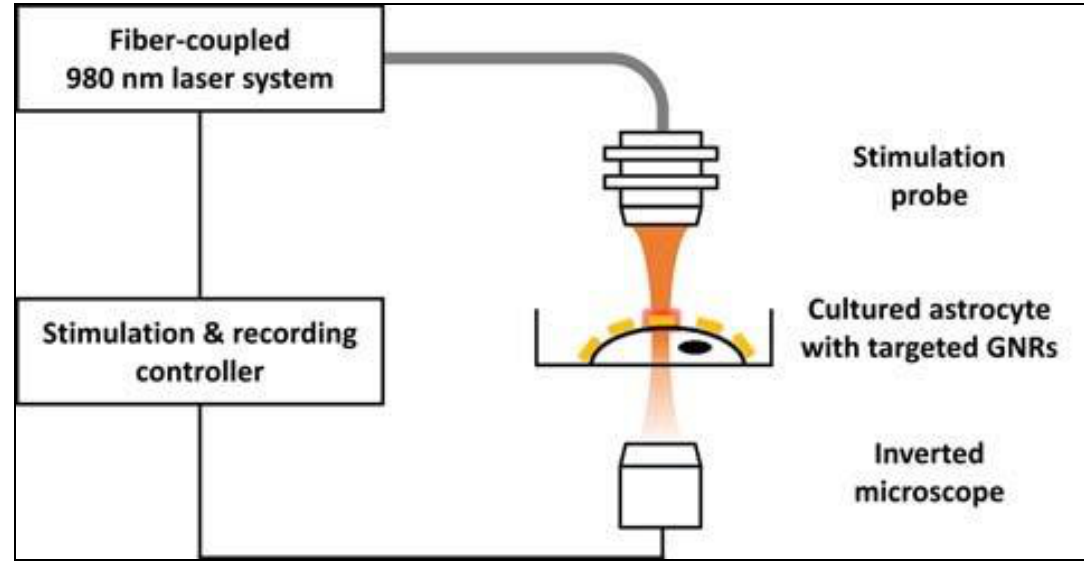
Figure 3. Experimental setup for cellular stimulation and calcium-sensitive dye imaging. Reproduced with permission from [33]. John Wiley and Sons, 2017.